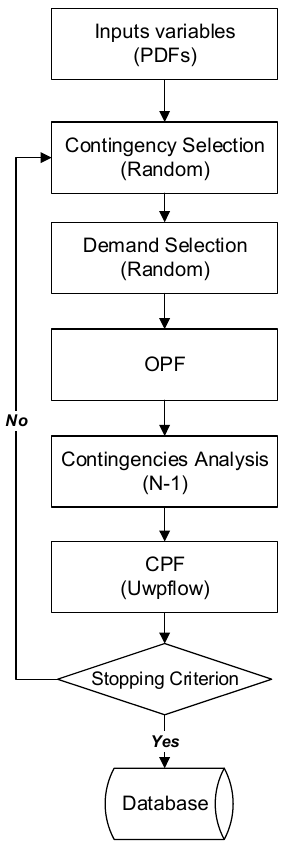
Figure 3. Flowchart of the Monte Carlo (MC) process to build database.